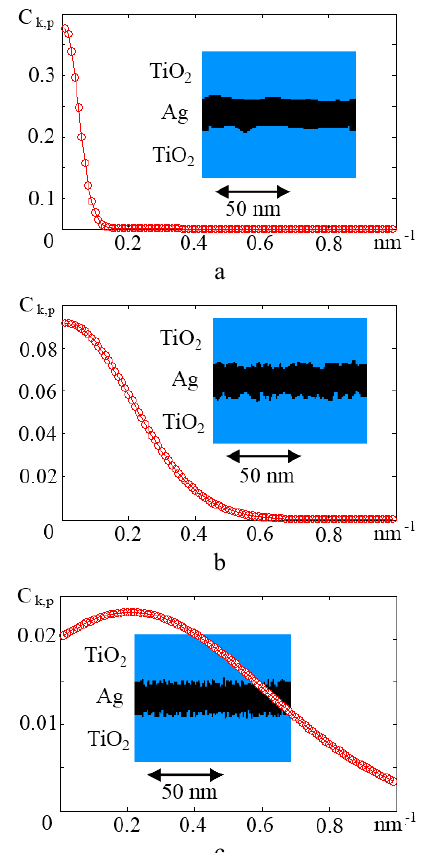
Figure 1: Examples surface profile realizations for different parameters of surface roughness of Ag layer, σ=1 nm, δ=0.04 nm -1 , ω=0.0 nm -1 (a); σ=1 nm,